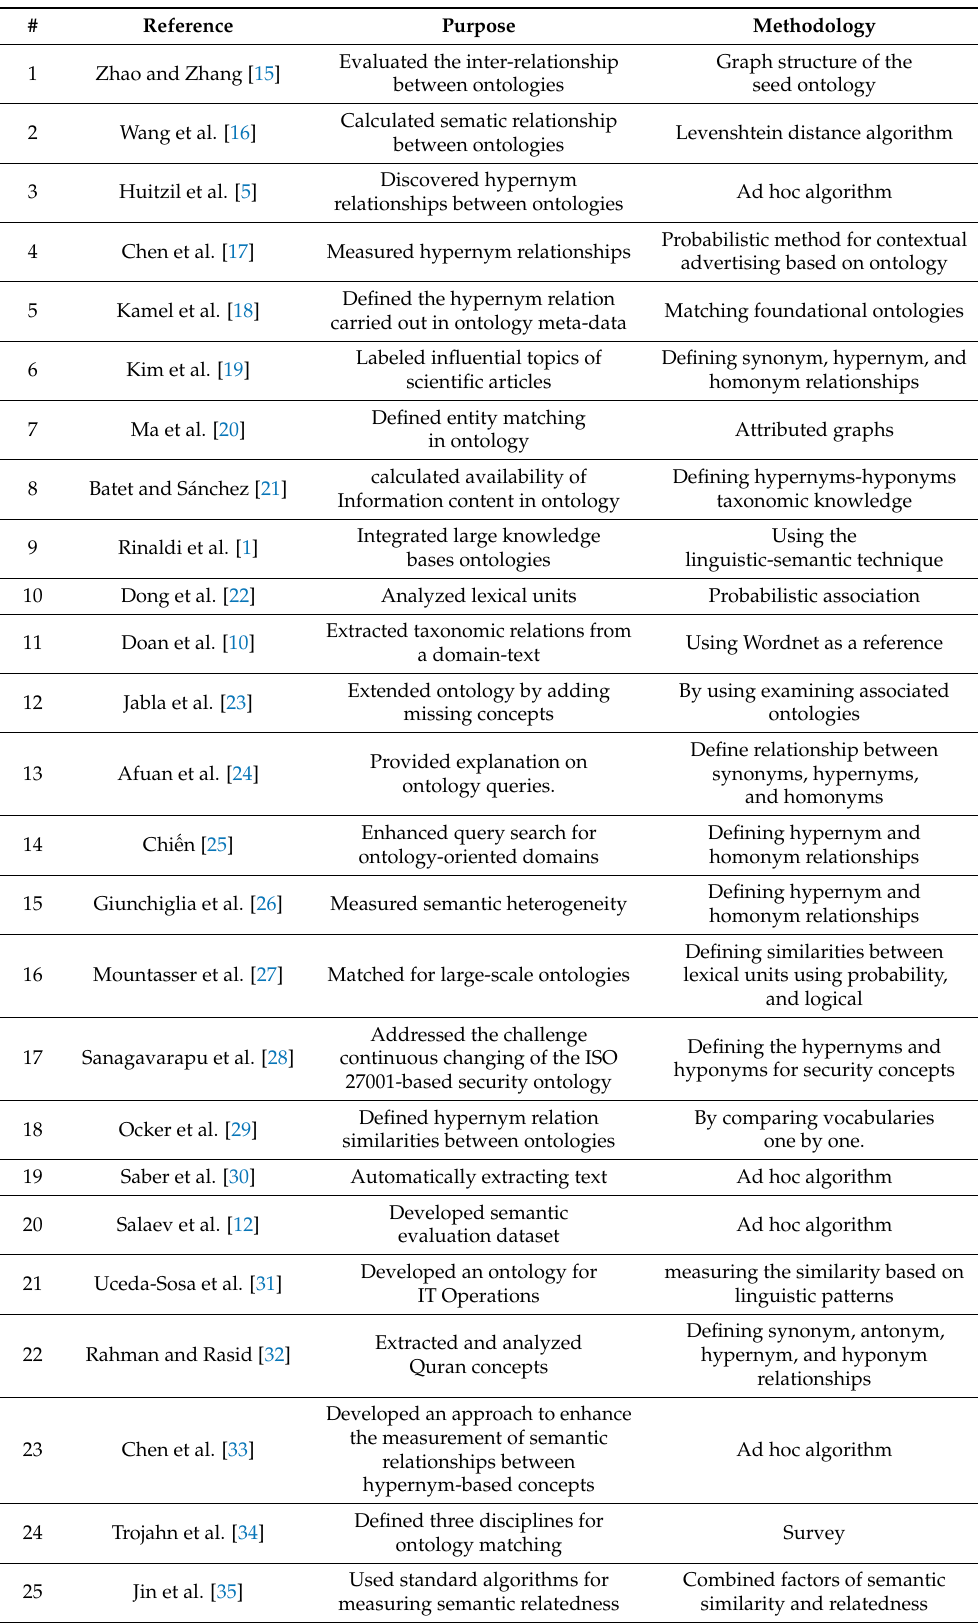
Table 1. Summary of related